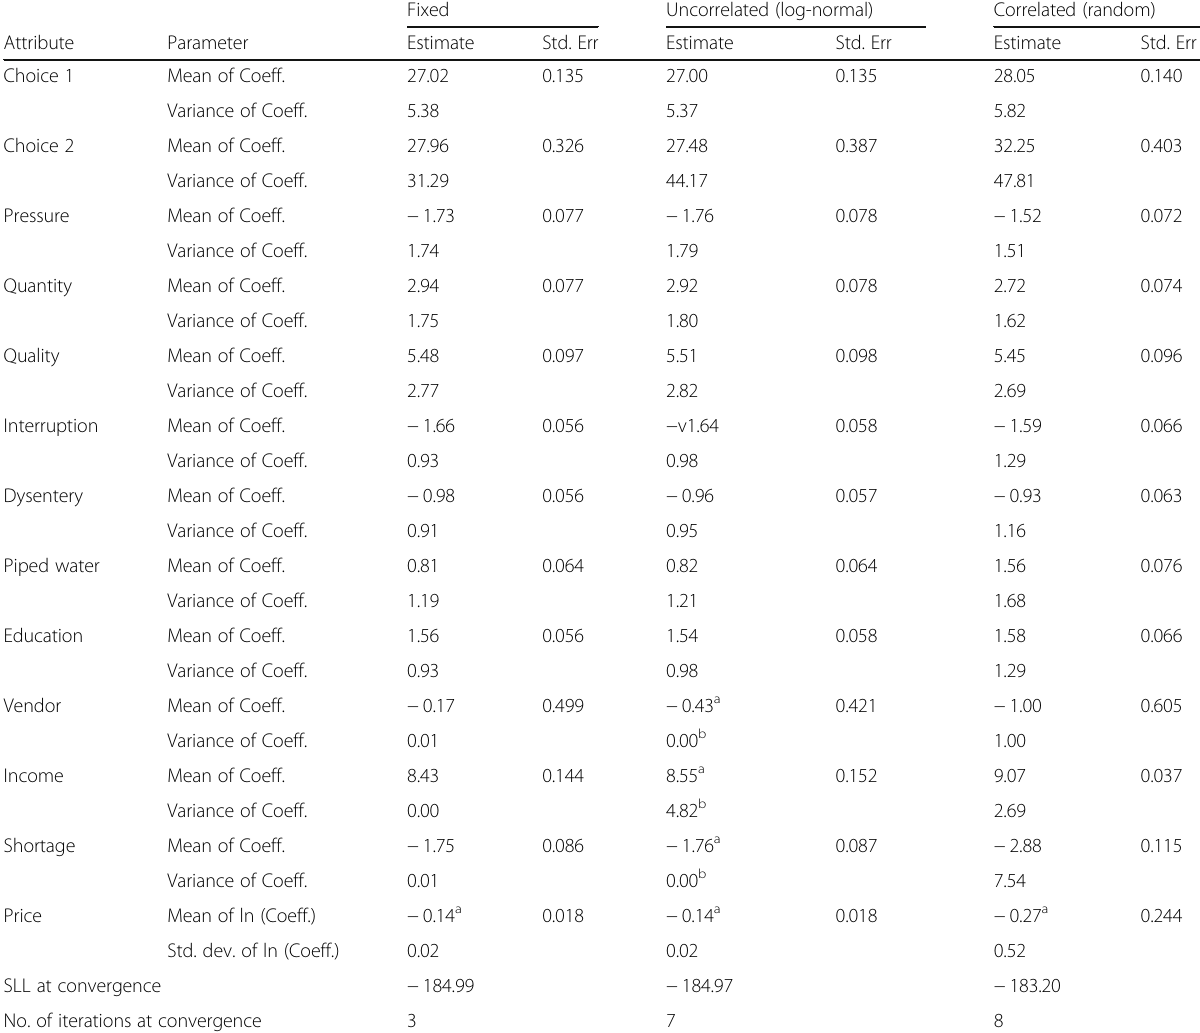
Table 5 Estimated coefficients (means and variances) of the three models in the WTP space